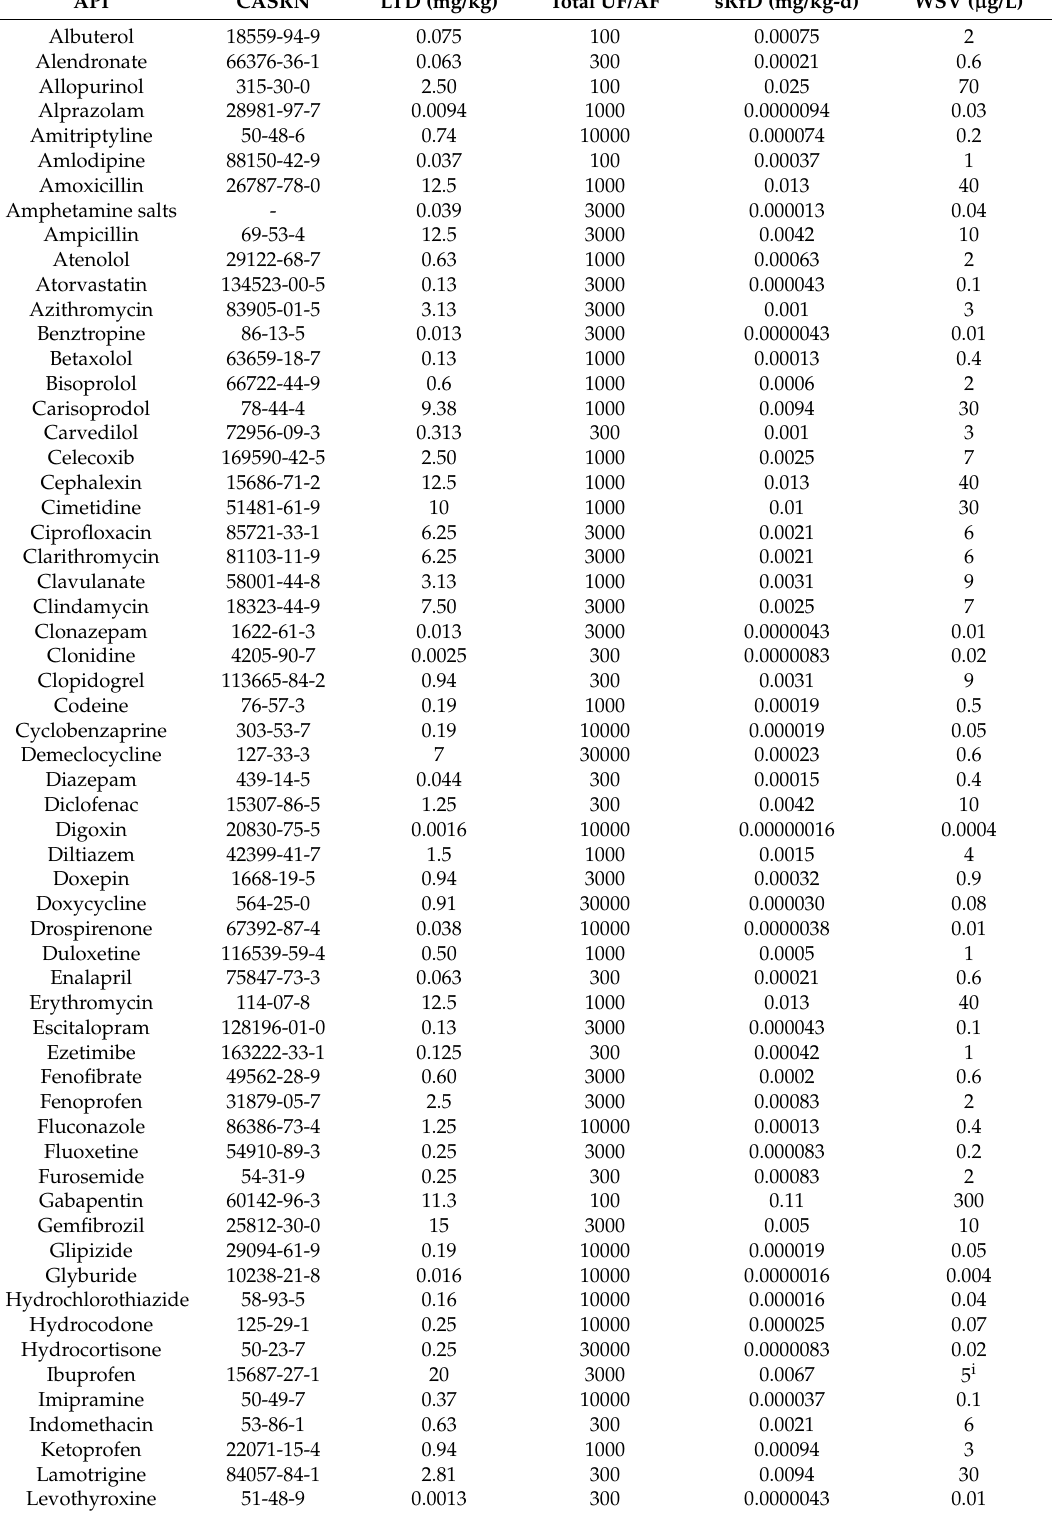
Table 3. Derived Water Screening Values (WSV), Screening Reference Doses (sRfD), Uncertainty and Adjustment Factor (UF/AF) application, and calculated Lowest Therapeutic Doses (LTD) for 119 APIs 1